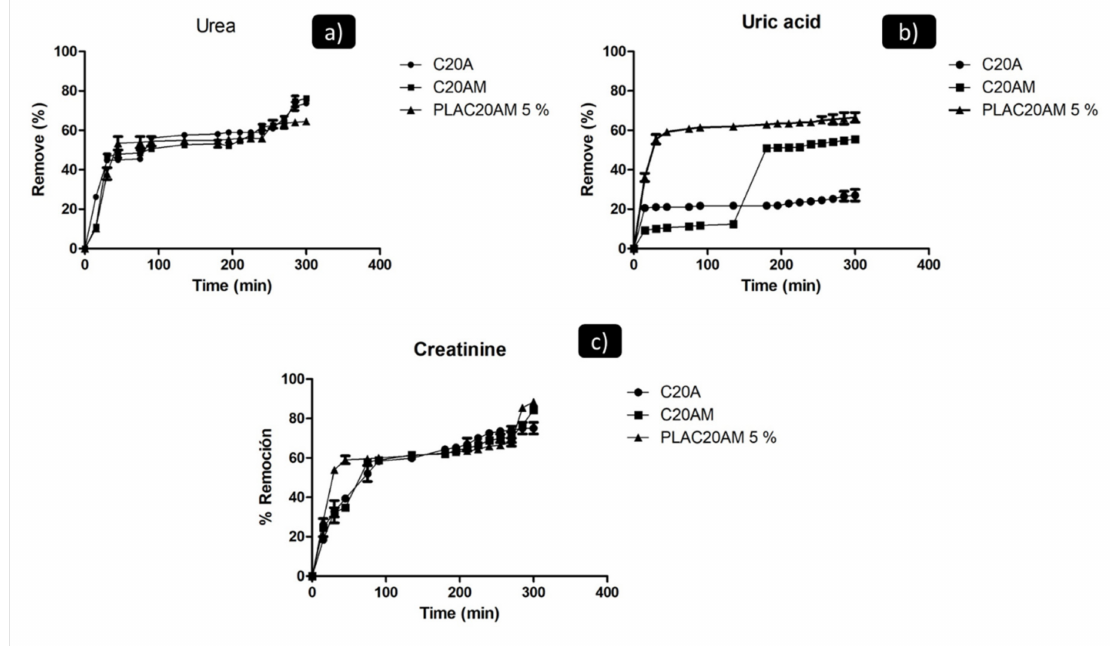
Figure 11. Removal percentage of ( a ) urea, ( b ) uric acid and ( c ) creatinine of the C20A, C20AM and PLAC20AM 5%. (Urea, uric acid and creatinine concentration = 160 mg/L, nanoclay and nanocomposite 20 mg/20 mL and t = 300